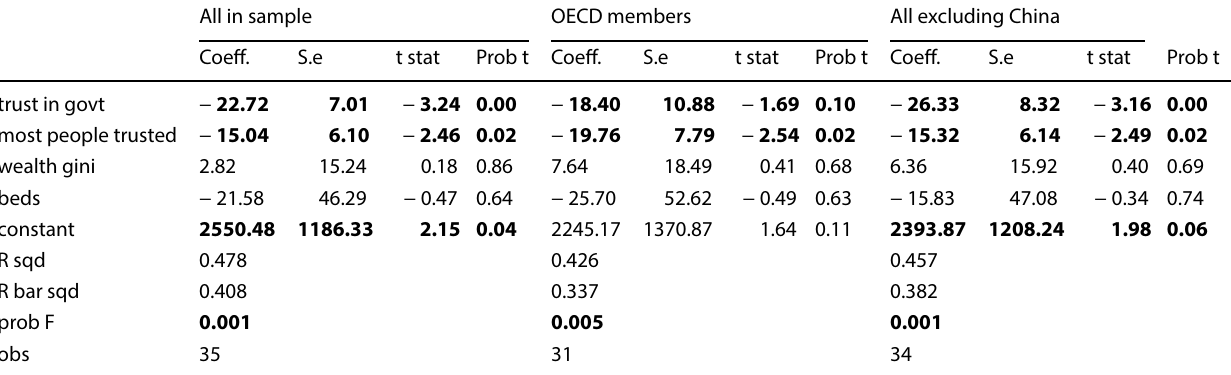
Table 4 Regression results for the entire period